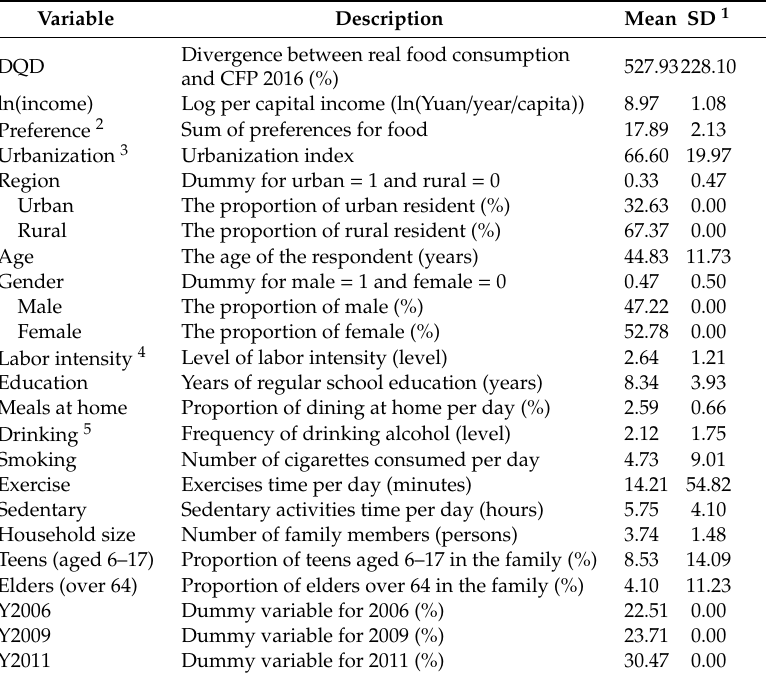
Table 2. Descriptive statistics of selected variables (n =